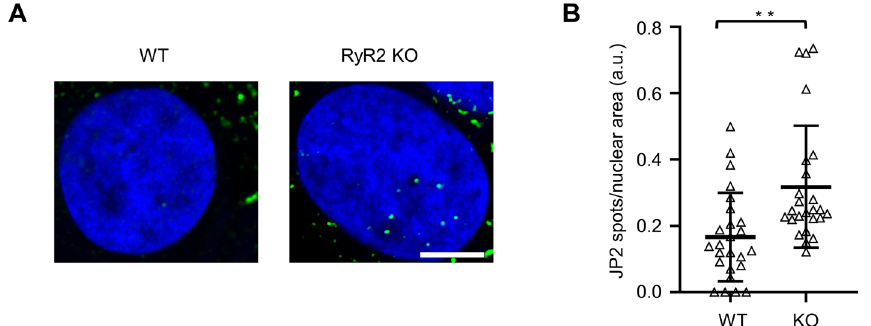
Figure 7. RyR2 knockout increases the number of discrete intranuclear JP2 signal spots in 2 months matured hiPSC-CMs. ( A ) Confocal images showing the DAPI-stained central nuclear imaging sections of WT versus RyR2 knockout hiPSC-CMs. Whereas one JP2 M epitope-labeled signal spot was apparent inside the WT hiPSC-CM nucleus, the number of signal spots was increased in RyR2 knockout hiPSC-CMs. Scale bar, 5 μm. ( B ) Dot plot comparing the intranuclear area-normalized number of JP2 signal spots between WT and RyR2 KO hiPSC-CMs. Data are represented as mean ± SD; n = 25 cells per group. Student’s t-test; ** p <